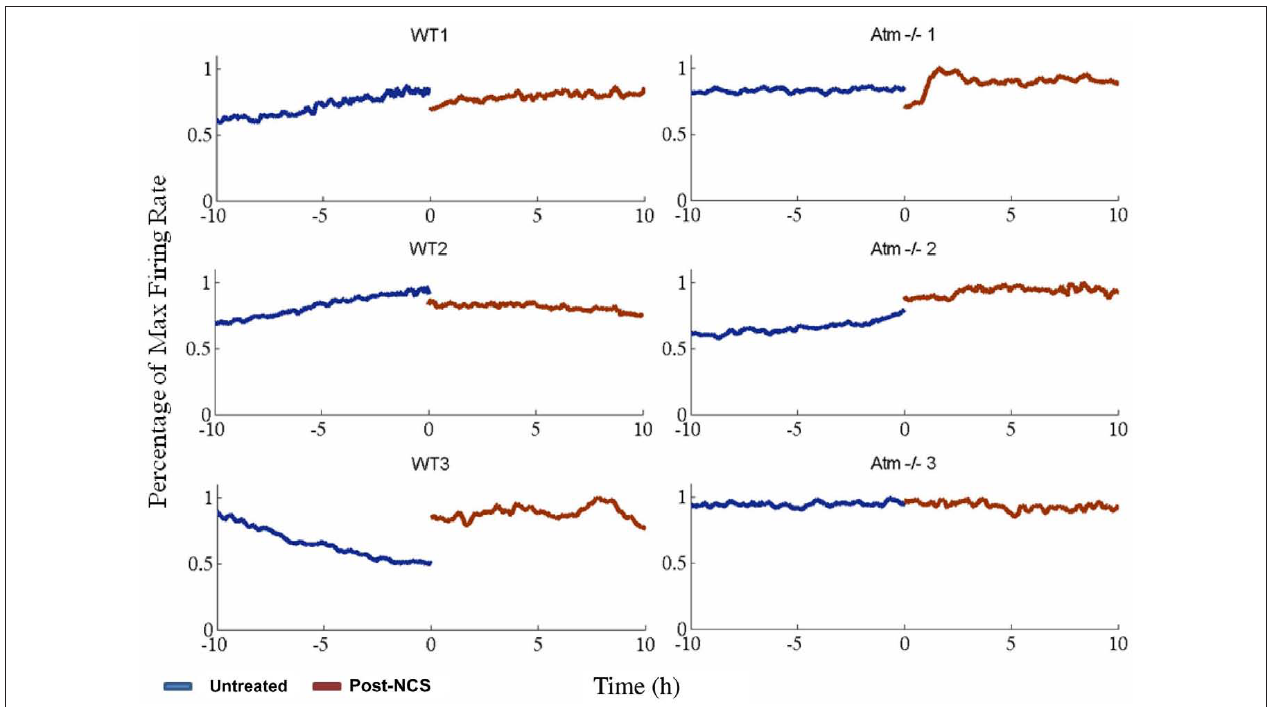
Figure 4 | Number of spikes detected in windows of 1000s with 250s steps. Blue lines indicate untreated networks, brown lines post NCS treatment. On the left: three examples of WT cultures, on the right: three Atm − / − samples. Though global firing rates vary across different cultures – representing the unique nature of